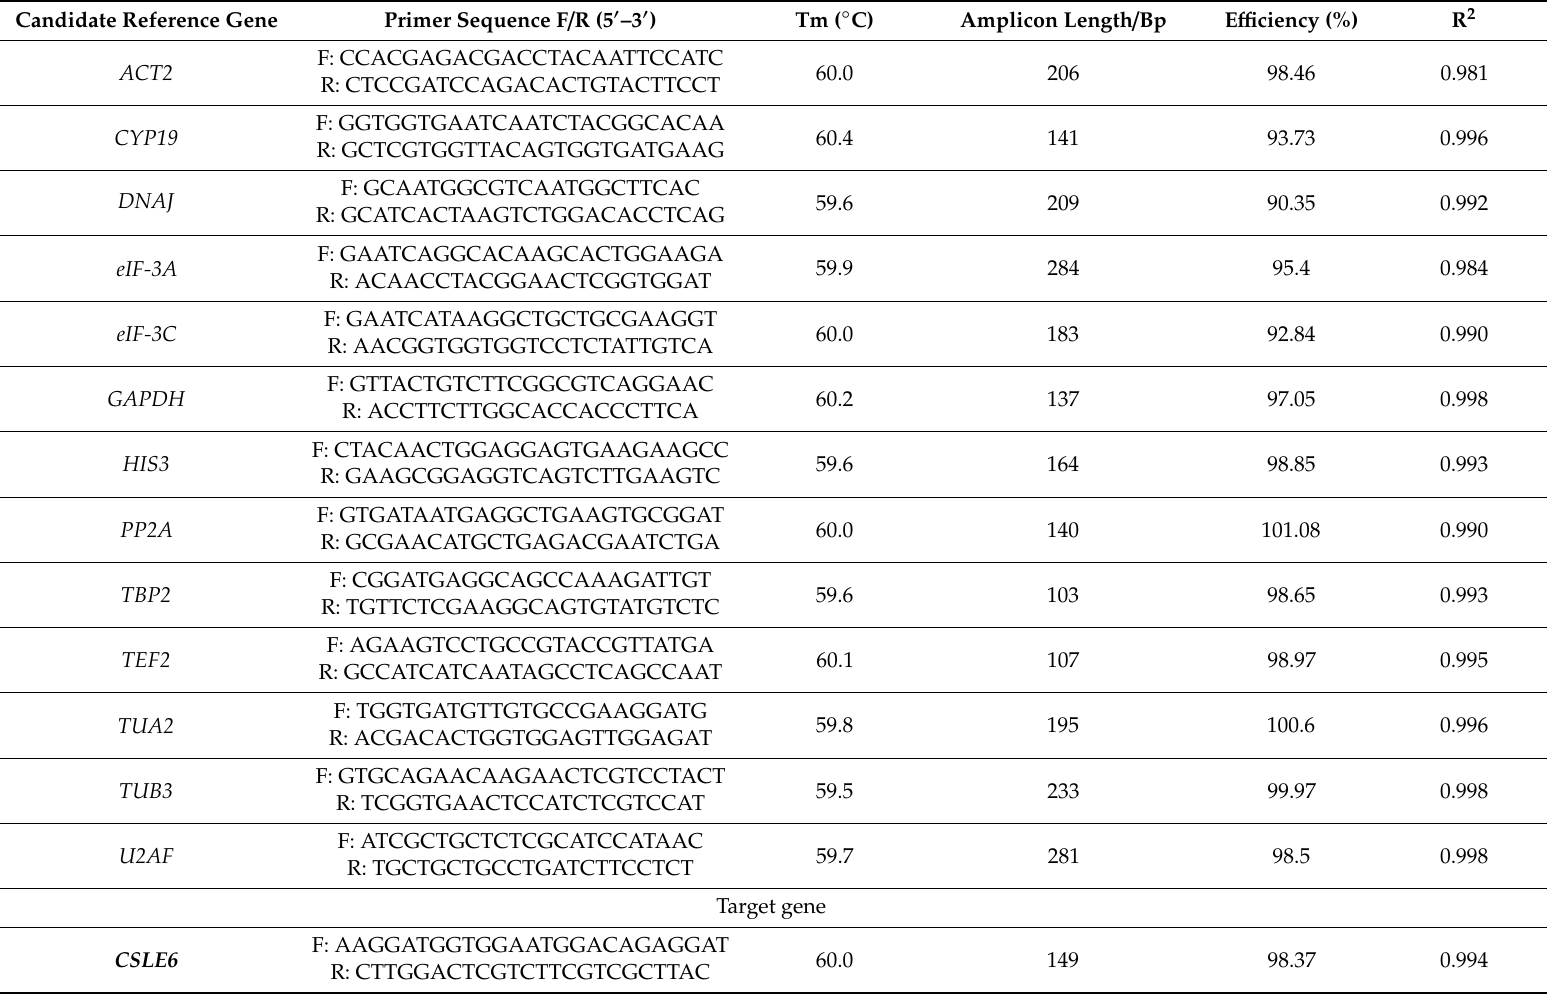
Table 3. Details of primers and amplicons for 14